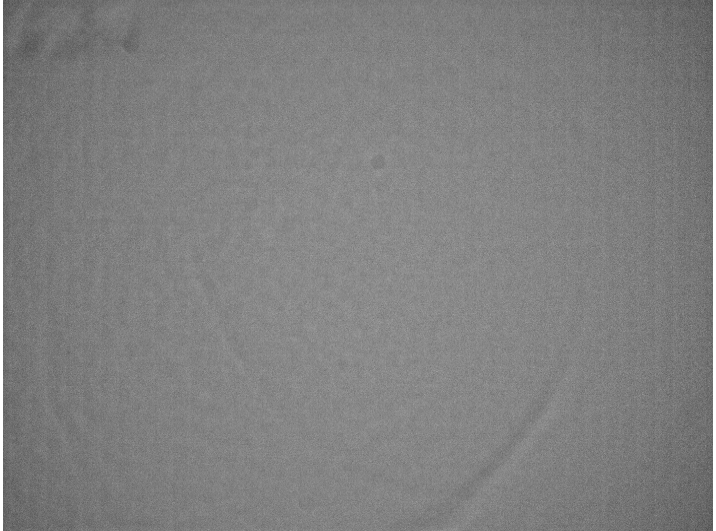
Figure 6. Static integrating sphere’s image